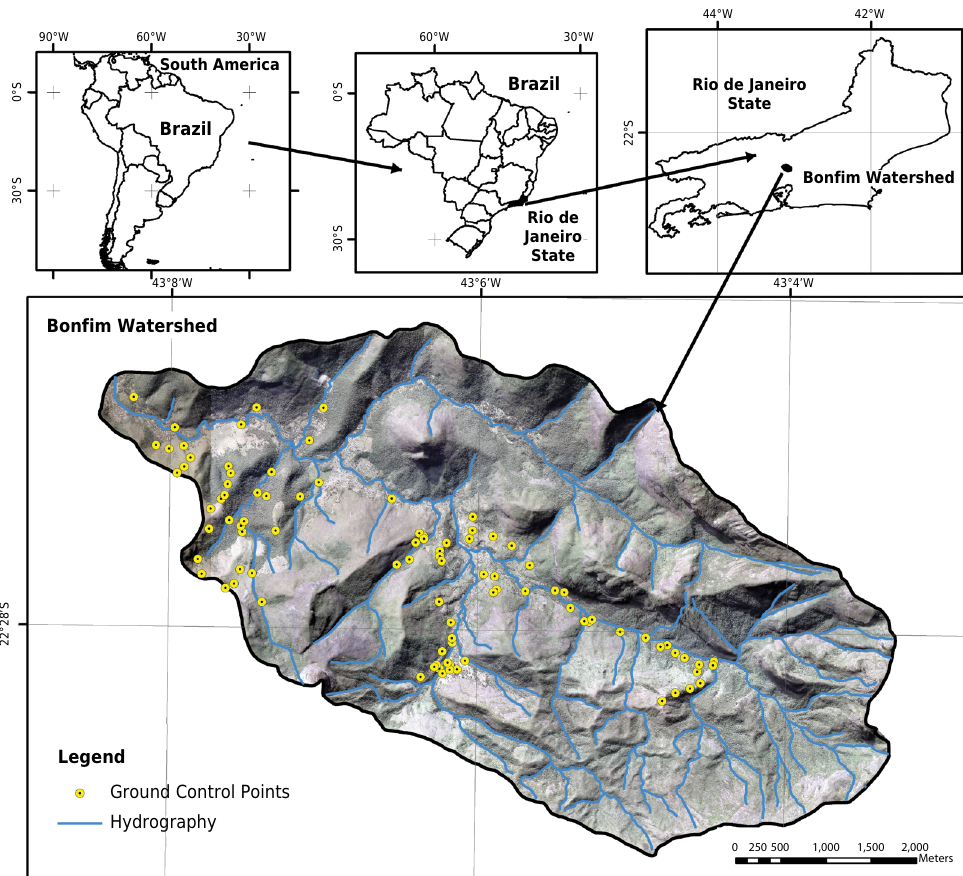
Figure 1. The location of Bonfim watershed and Ground Control Points over an orthophoto and its location in South America, Brazil, and Rio de Janeiro